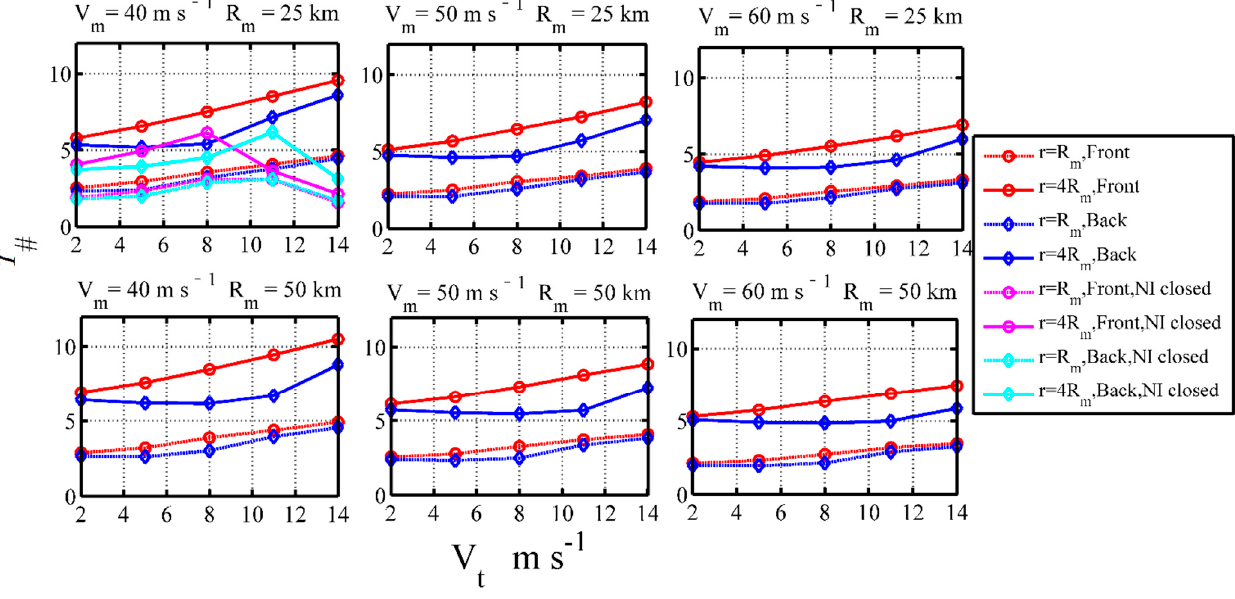
Figure 5. Modelling results of T # . The lines correspond to different radial distances, such as r = R m , and sectors in terms of front or back and model setting with nonlinear interaction (NI) closed or not.